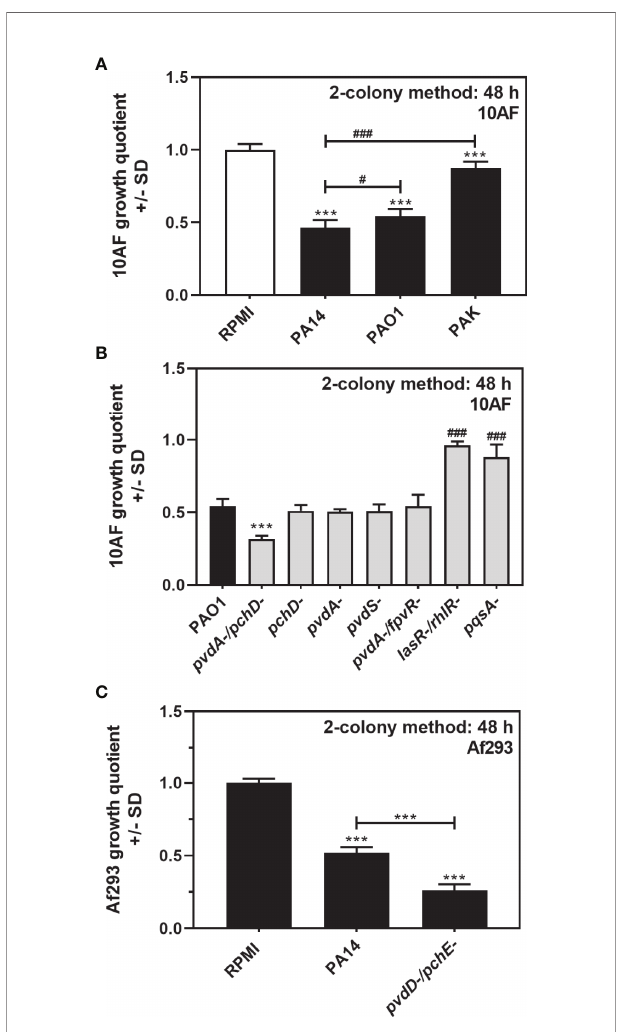
FIGURE 4 | P. aeruginosa antifungal activity on agar is not strain-dependent. (A) Six-millimeter paper disks were placed on RPMI agar. Ten microliters of A. fumigatus 10AF conidia (10 7 /ml, prepared in RPMI) was placed on each disk, and 10 µl of PA14, PAO1, or PAK wild-type bacteria (10 9 /ml, prepared in RPMI) was placed 15 mm distant from the disks carrying 10AF. Plates were incubated for 48 h at 37°C, and growth quotients were determined by the two-colony method. Comparison: RPMI control (white bar) vs. all other bars, or as indicated by the ends of the brackets. (B) Six-millimeter paper disks were placed on RPMI agar. Ten microliters of A. fumigatus 10AF conidia (10 7 / ml, prepared in RPMI) was placed on each disk, and 10 µl of PAO1 or seven PAO1 mutant bacteria (10 9 /ml, prepared in RPMI) was placed 15 mm distant from the disks carrying 10AF. Plates were incubated for 48 h at 37°C, and growth quotients were determined by the two-colony method. Comparison: PAO1 (black bar) vs. all other bars. (C) Six-millimeter paper disks were placed on RPMI agar. Ten microliters of A. fumigatus Af293 conidia (10 7 /ml, prepared in RPMI) was placed on each disk, and 10 µl of PA14 wild-type or PA14 pvdD-/pchE- bacteria (10 9 /ml, prepared in RPMI) was placed 15 mm distant from the disks carrying Af293. Plates were incubated for 48 h at 37°C, and growth quotients were determined by the two-colony method. Comparison: RPMI control vs . all other bars, or as indicated by the ends of the bracket. Statistical analysis in (A – C) , t-test: one, or three asterisks or pound signs = p ≤ 0.05 and p ≤ 0.001, respectively. Asterisks represent signi fi cant increases in antifungal activity; pound signs represent signi fi cant